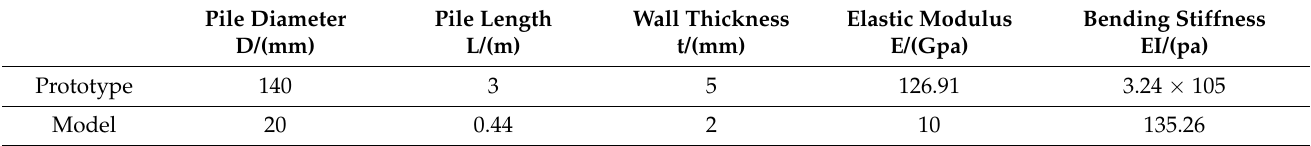
Table 1. Model anchor pile